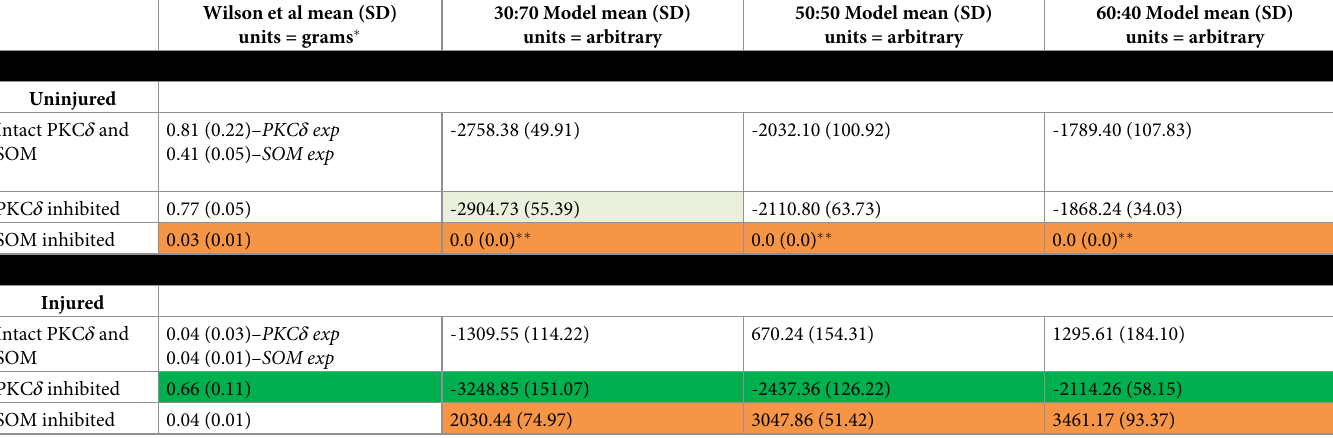
Table 4. Pain output from wet lab experiment (Wilson et al) and three models. Cells are shaded to indicate relative change of that individual cell from the “Intact” value found with intact PKC δ and SOM signaling (i.e. no inhibition). Dark green is an analgesic effect compared to intact condition and light green is a small analgesic effect compared to intact. Dark orange is a hyperalgesic effect compared to intact. No shading represents a lack of significant change from the intact value. Intact values from Wilson et al[16] are reported from two separate experiments labeled as “PKC δ exp” and “SOM